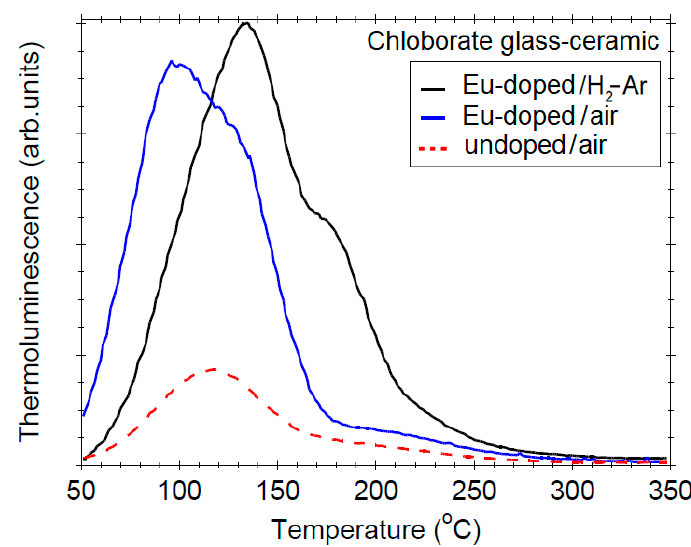
Figure 8. Normalized thermoluminescence curves recorded on undoped and Eu-doped chloroborate glass-ceramics after x-ray irradiation at room temperature.